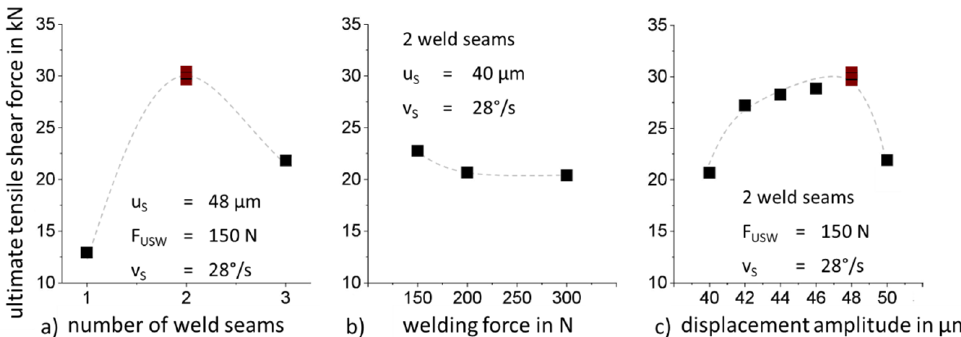
Figure 11. Ultimate tensile shear force depending on the process parameters: ( a ) Number of weld seams, ( b ) welding force and ( c ) displacement amplitude of the sonotrode.